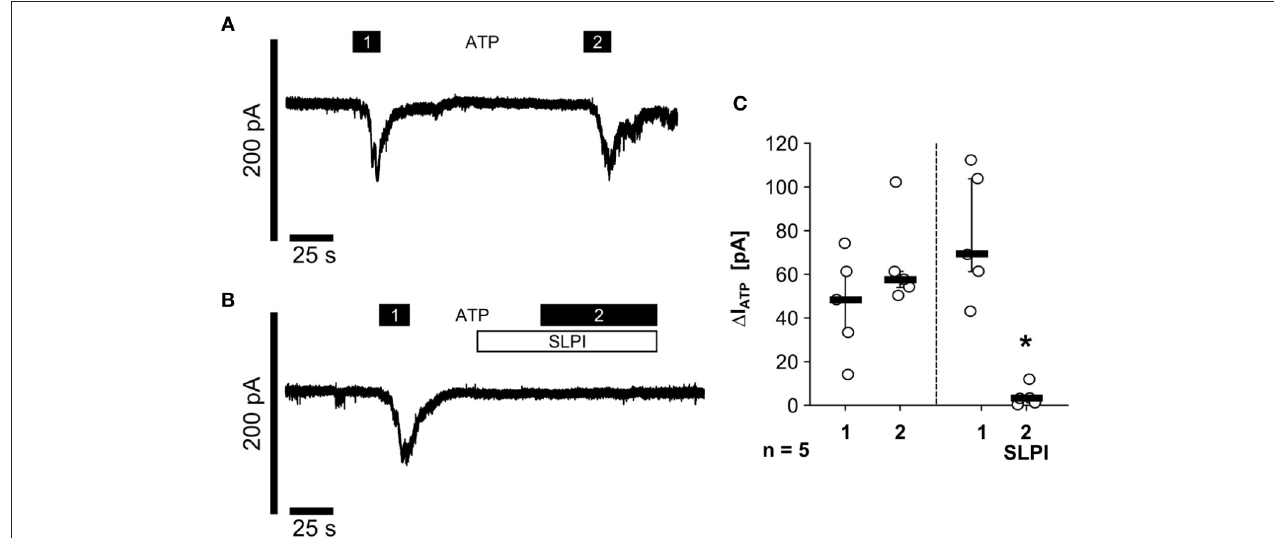
FIGURE 5 | SLPI inhibits the function of monocytic ATP receptors. Human monocytic U937 cells were primed with LPS (1 µ g/ml, for 5h). Whole-cell patch-clamp recordings were performed and ion-current changes in response to two applications (1 and 2) of ATP (1mM) were recorded in the absence (A,C) or presence (B,C) of SLPI (10 µ g/ml). (C) All ATP-induced current changes ( 1 I ATP ) are presented as individual data points, bars indicate median, whiskers percentiles 25 and 75, experimental groups were compared by Wilcoxon signed-rank test; * p ≤ 0.05 significantly different compared to the first 1 I ATP .